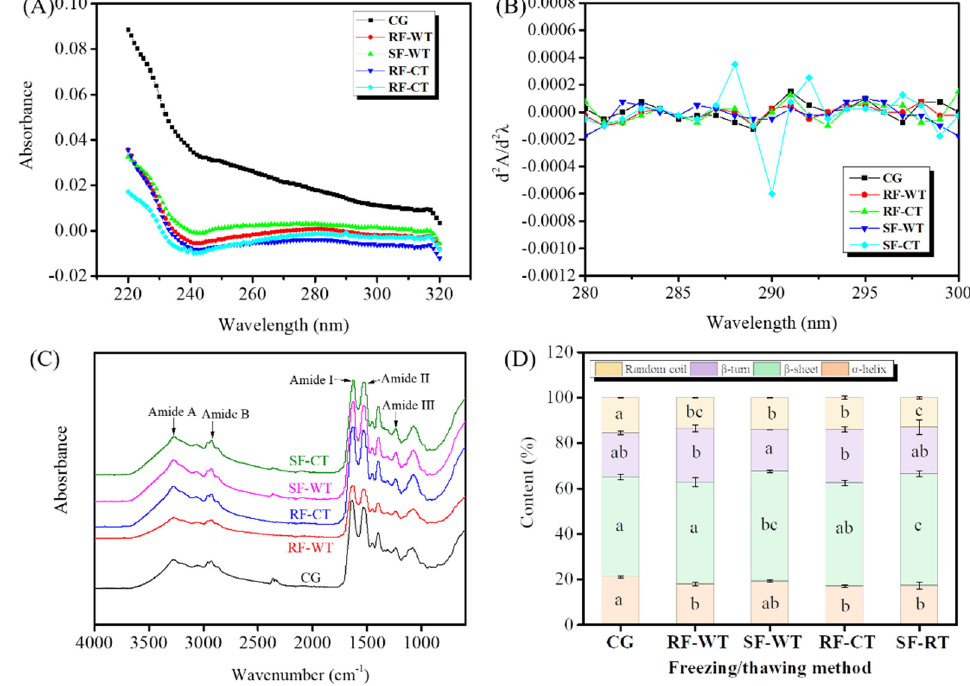
Figure 5. UV spectra ( A ), second-derivative UV spectra ( B ), FTIR spectrum ( C ), and protein secondary structures ( D ) of meat gels from crayfish subjected to different freeze-thawing treatments. CG, control group; RF, rapid freezing; SF, slow freezing; CT, cold thawing; WT, water immersing thawing. Different letters (a–c) in ( D ) for the content of protein secondary structures indicate significant differences ( p < 0.05).